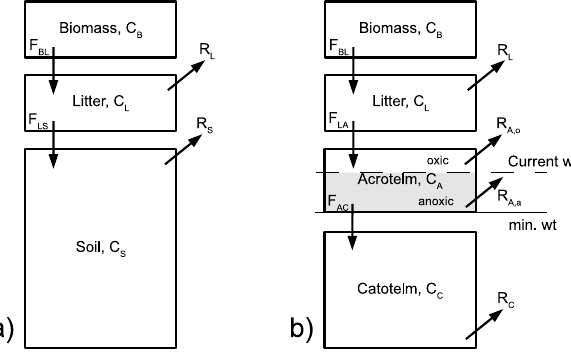
Fig. 1. The LPJ soil carbon pools C X and fluxes F XY and R k . (a) non-wetland soil, (b) wetland soil. Suffixes X, Y, k designate the carbon pools with B (biomass), L (Litter), S (Soil), A (Acrotelm) and C Fig.1.TheLPJsoil arbonpoolsCXand(cid:3)uxesFXYandRk.a) non-wetlandsoil,b)wetlandsoil.Suf(cid:2)xesX,Y,kdesignatethe arbonpoolswithB(biomass),L(Litter),S(Soil),A(A rotelm)